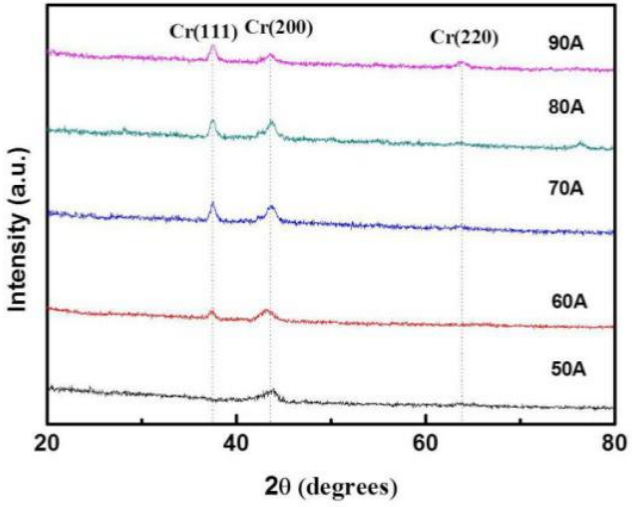
Figure 2. XRD patterns of CrSiN coatings deposited under different CrSi arc currents.